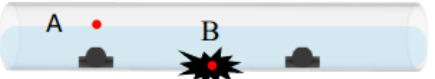
Figure 7. Schematic of broken pipeline with hall sensors.